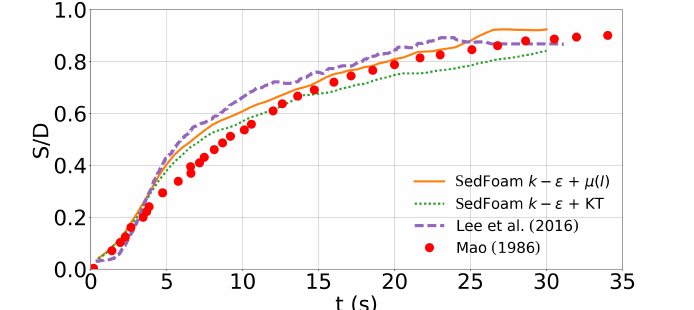
Figure 2. Time evolution of the maximum scour depth for simulations with the k − ε turbulence model using µ ( I ) rheology (orange line) and kinetic theory (green dotted line) compared with the experimental data from Mao (1986) [2] (red dots) and numerical data from Lee et al. (2016) [12] (purple dashed line).